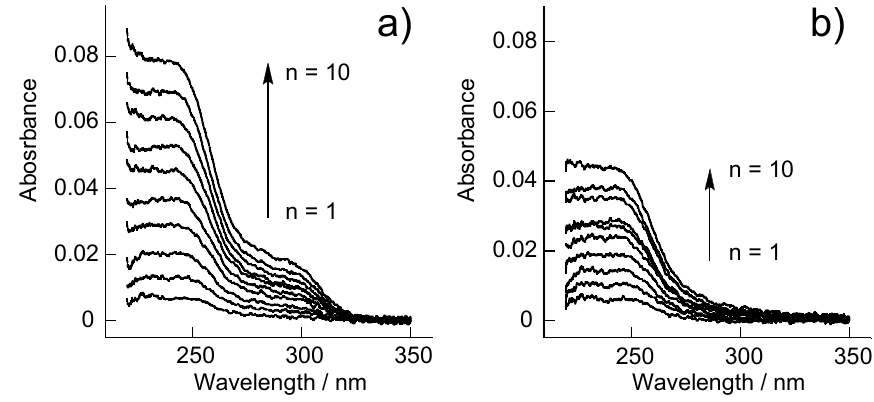
Figure 5. UV-vis absorption spectra during the preparation of (SA-PAH/PBA-PAH) n films in a 10 mM CHES buffer (pH 9.0) in the presence of 1 M NaCl ( a ) or 150 mM NaCl ( b ).